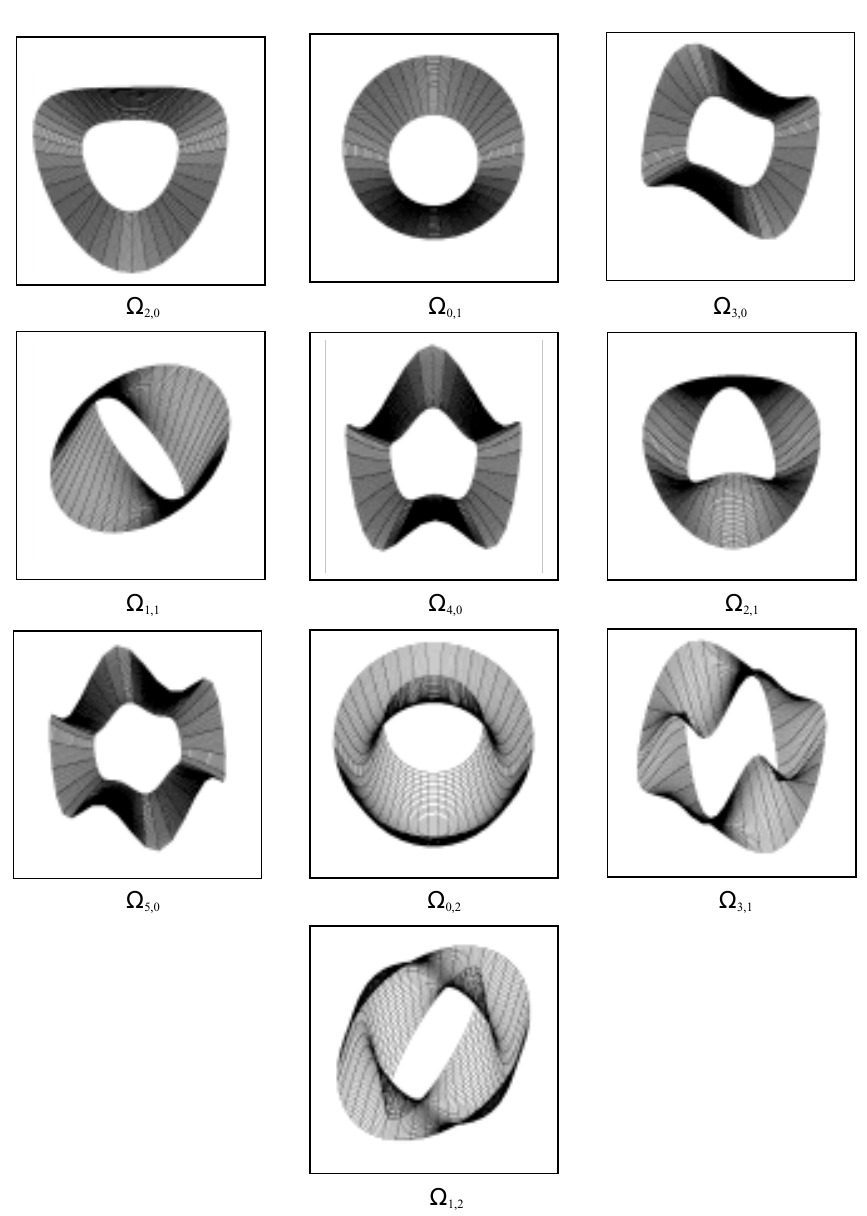
Fig. 9. Three dimensional plots for first ten normal modes of vibration for F - F plate when α = β = 0.4, e r = g r = 5.0, R 0 = 0.5, K f =